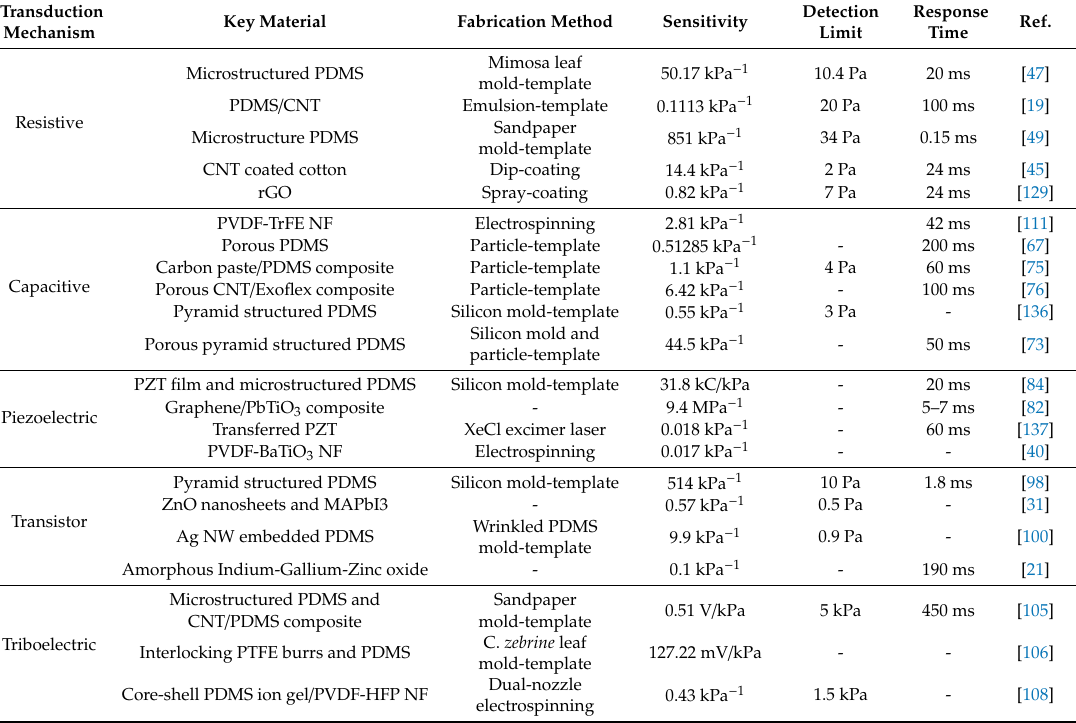
Table 1. Summary of some pressure sensors and their electrical